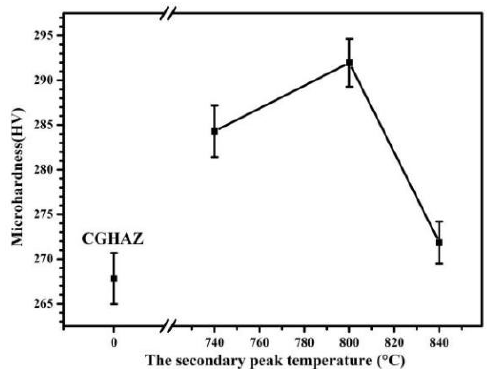
Figure 5. Micro-hardness of the simulated CGHAZ and ICCGHAZs with different secondary peak temperatures.